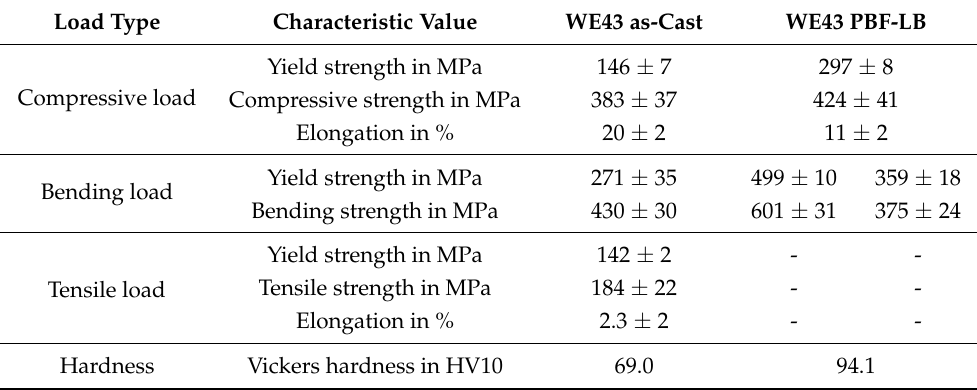
Table 5. Mechanical properties of as-cast and PBF-LB-generated WE43